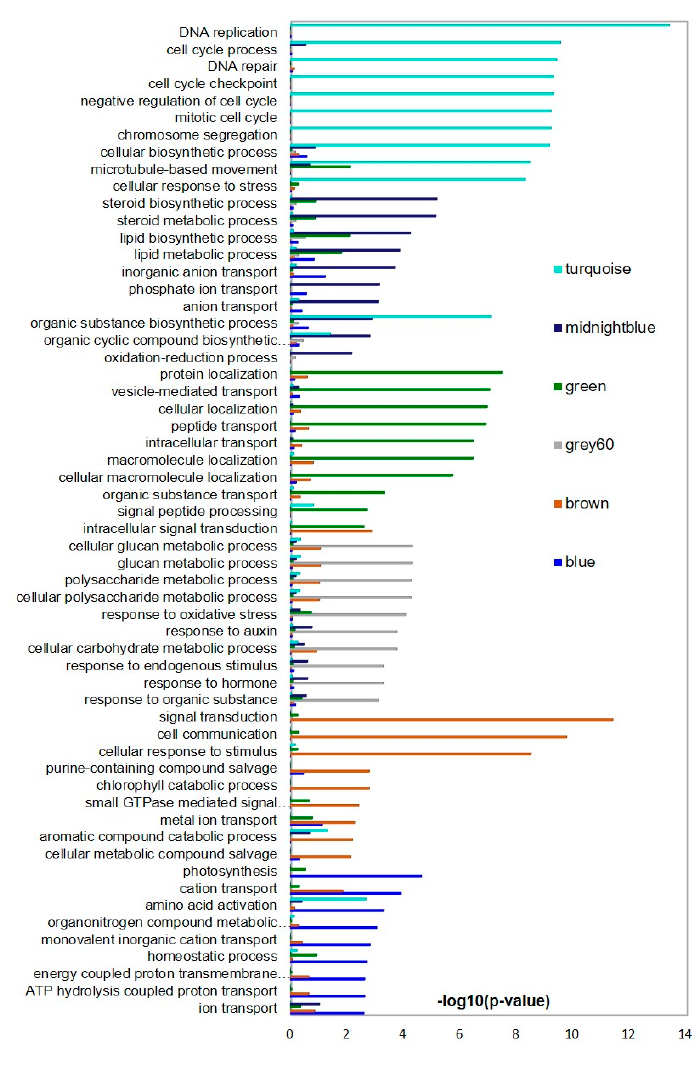
Figure 7. Gene Ontology (GO) enrichment of genes from six coexpressed WGCNA modules. p values were calculated using topGO and the top10 enriched GO terms in biological processes were listed.